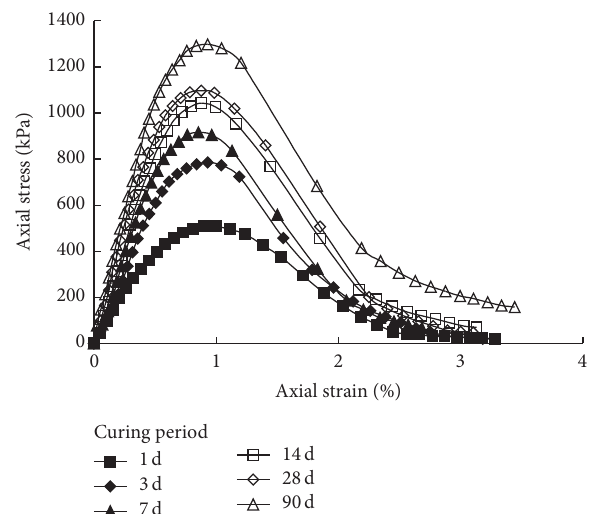
Figure 3: Axial stress-axial strain relationship for different curing periods at the unconfined compression condition.